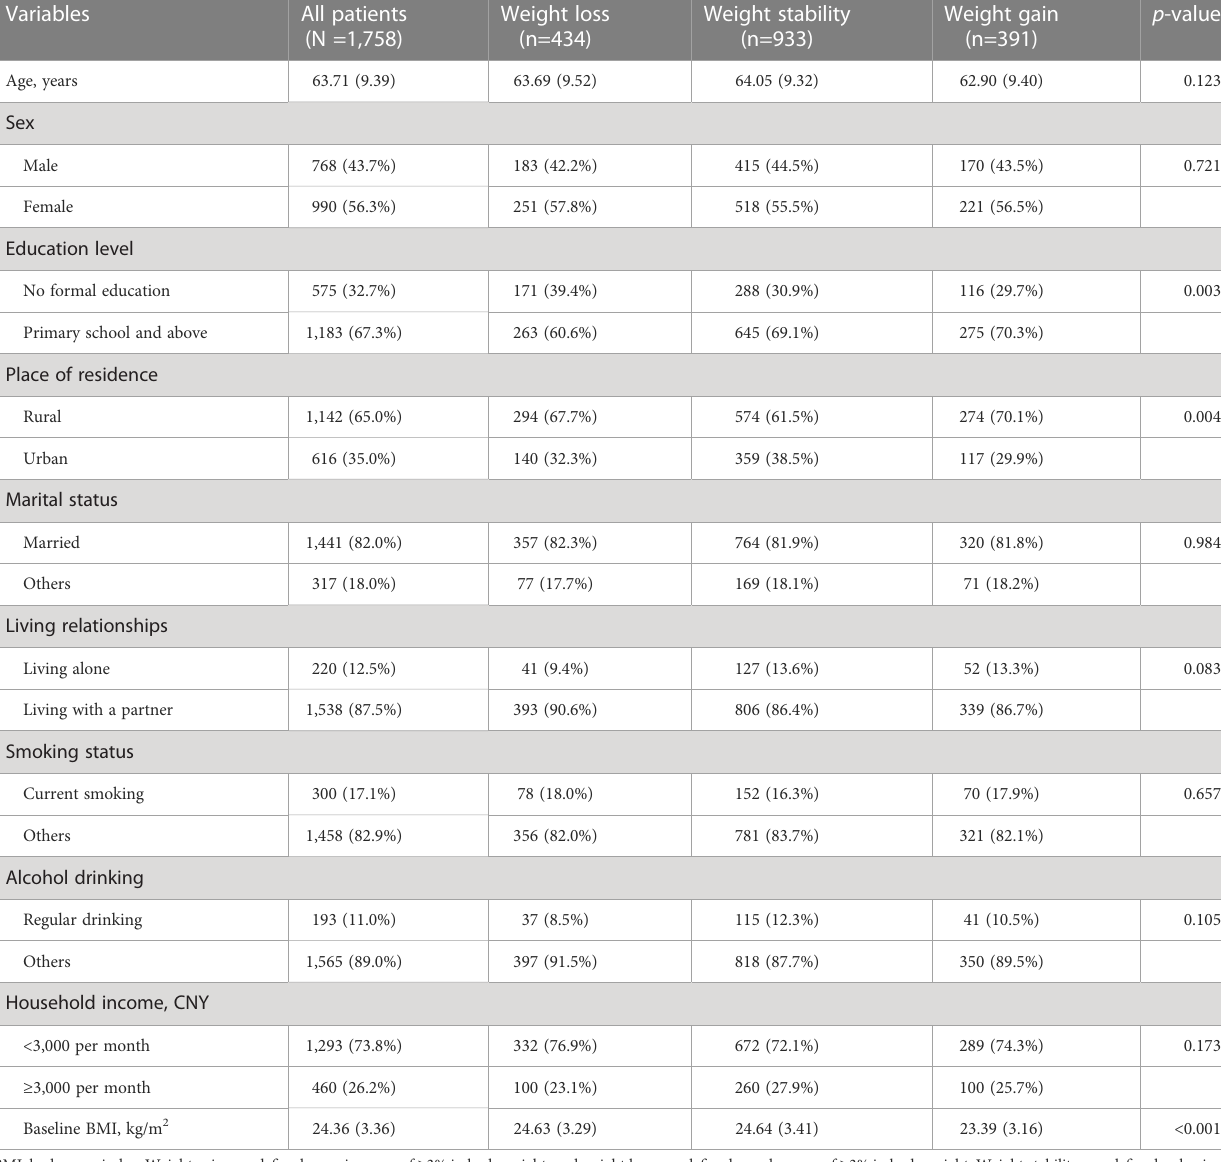
TABLE 1 Baseline characteristics of study participants by different weight change